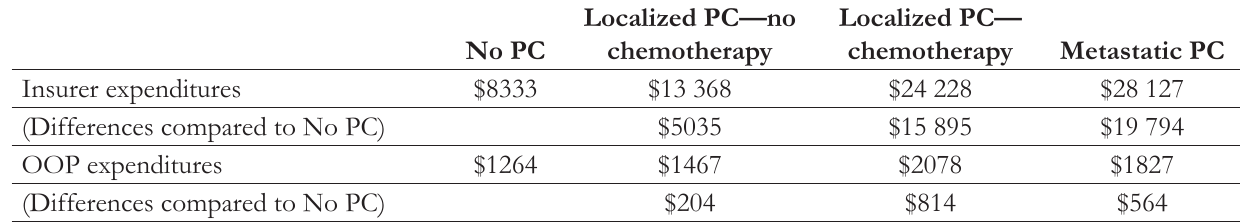
Table 5. Effects of PC on Expected Per-patient Healthcare Expenditures [per annum, 2011 dollars]